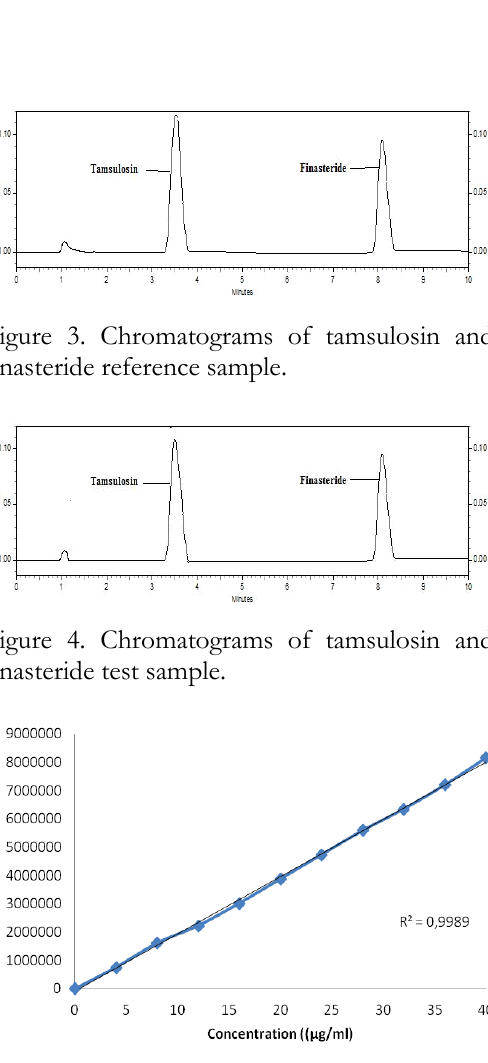
Figure 5. Linearity curve of Tamsulosin.